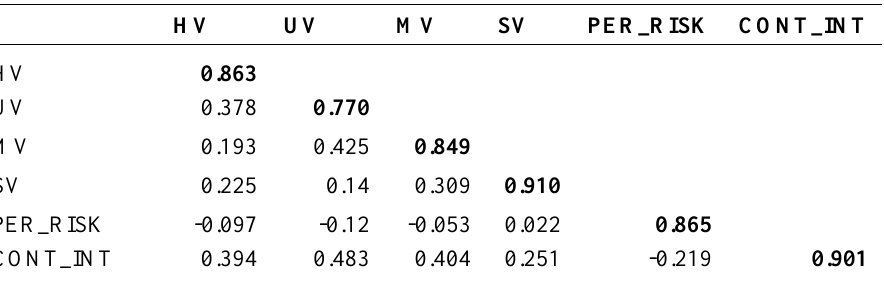
Table 3: Inter-Construct